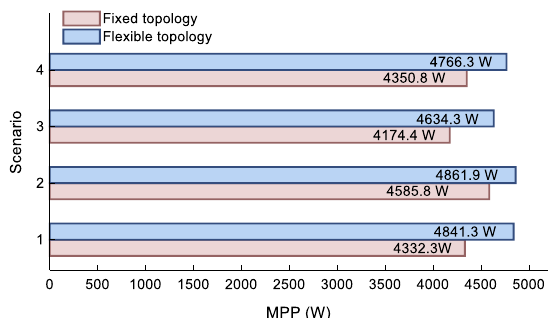
Fig. 11 MPP performance comparison under the four mismatch scenarios